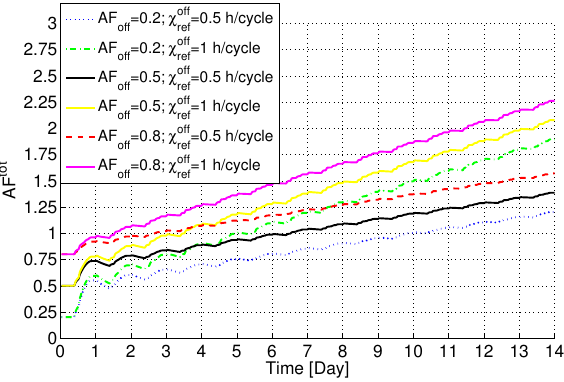
Figure 10. AF tot in the network vs. time for different HW parameters for the LTE